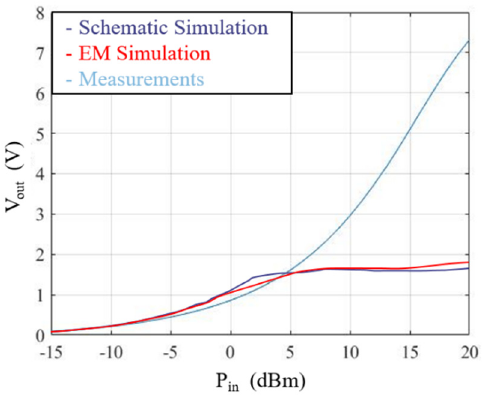
Figure 11. Simulated RF–DC converter circuit DC output voltage results.